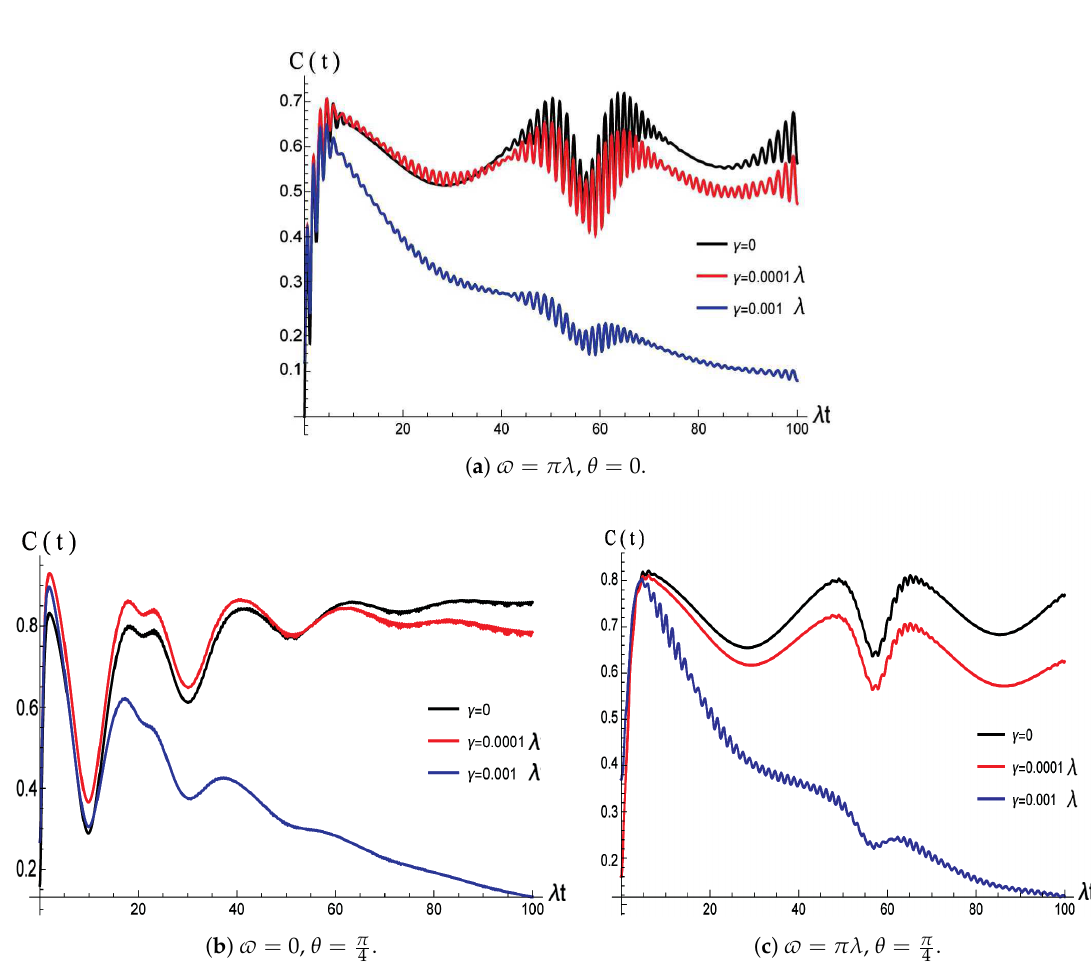
Figure 3. The evolution of concurrence C ( t ) vs. the scaled time, for the one-photon process ( κ = 1), ω j = Ω j = 0.1 λ , Γ j = 0, and ¯ n j =